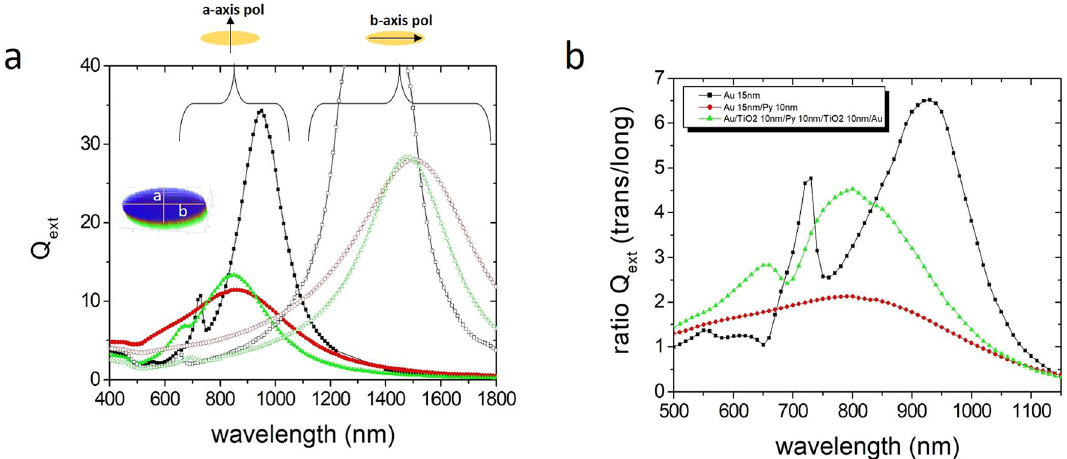
Figure 6. Simulated extinction factors Q ext for different ellipses stacks. ( a ) Q ext for light polarization parallel to the short and long axis as indicated by the inserts, for only Au (black), Au/Py (red), and Au/TiO 2 /Py/TiO 2 /Au (green). ( b ) The ratio of transversal/longitudinal extinction factors Q ext . The five-layer stack shows a pronounced peak at 800